Question: Compose a caption that would accompany this figure in a paper.
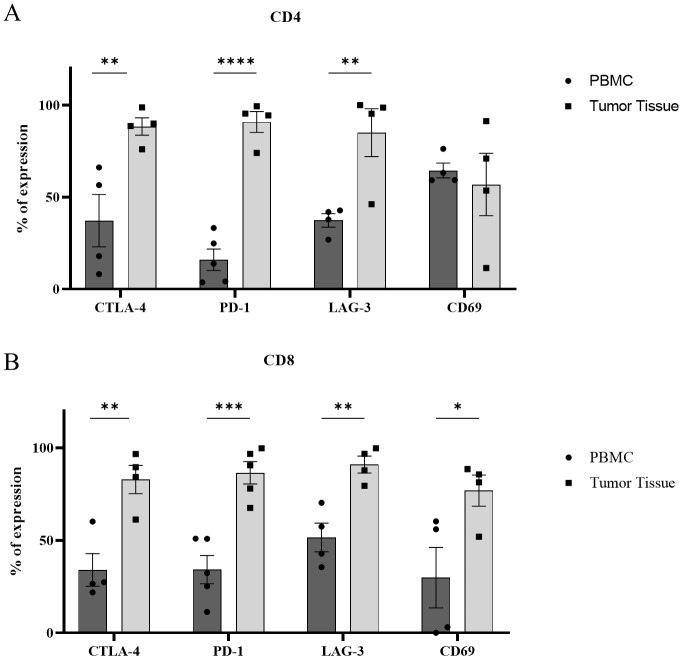
Answer: Checkpoint expression in T-cells isolated from the blood or the tumor tissue of PDAC patients. Checkpoint expression in CD4 + (A) and CD8 + (B) T-cells isolated from the blood or the tumor tissue of PDAC patients was analyzed by flow cytometry. T-cells identified as CD3 + and CD45 + were analyzed for surface expression of CTLA-4, PD-1, LAG-3 and CD69. T-cells isolated from the tumor tissue were compared to T-cells isolated from the blood. Error bars indicate the standard errors of the mean of four independent patients, with **p ≤ 0.01; ***p ≤ 0.005; ****p ≤ 0.0001.